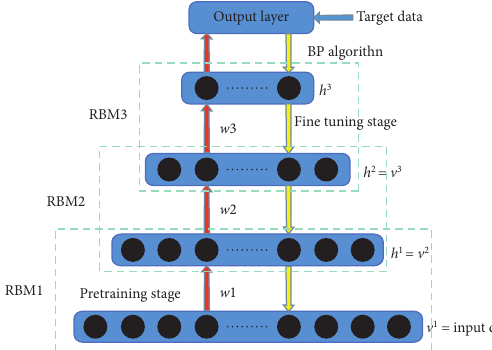
Figure 1: Architecture of the